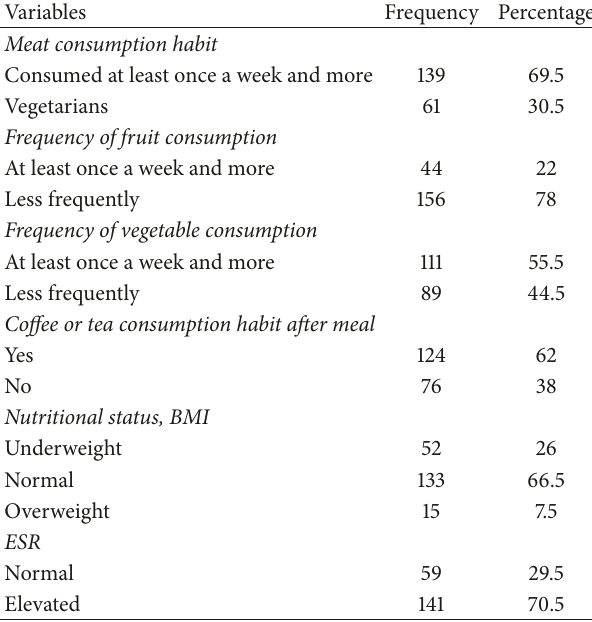
Table 2: Dietary habit, nutritional status, and ESR value of study participants ( 𝑛 = 200 ).